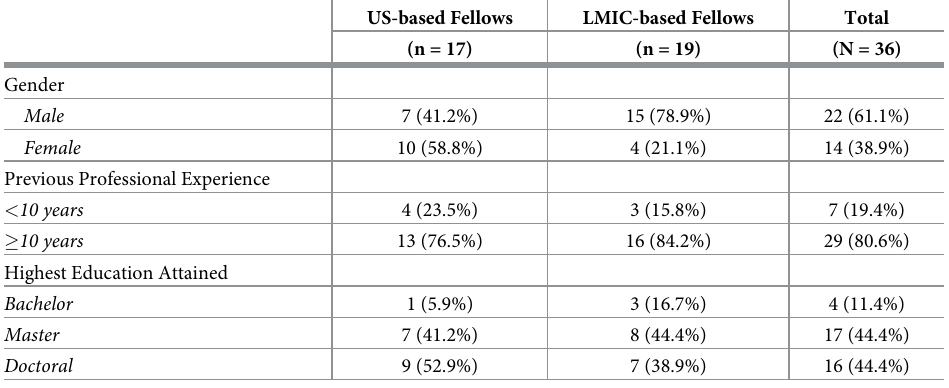
Table 1. Characteristics and main areas of focus for US-based versus LMIC-based